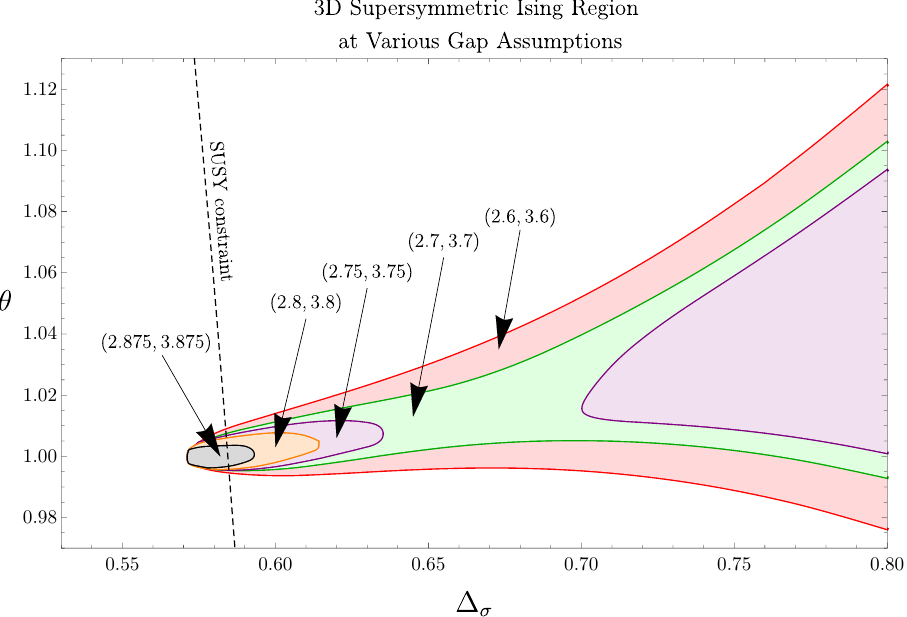
Figure 6 . A plot of the non-excluded regions at various gap assumptions in ((cid:1) (cid:27) ; (cid:18) ) space along the supersymmetric line (cid:1) (cid:15) = (cid:1) (cid:27) + 1. Again, we assume a second relevant parity-odd operator (cid:27) 0 and study di(cid:11)erent values of the gap until (cid:1) (cid:27) 0 = (cid:1) (cid:15) 0 (cid:0) 1. The shaded areas were obtained at derivative order (cid:3) = 25 and denote the non-excluded points.